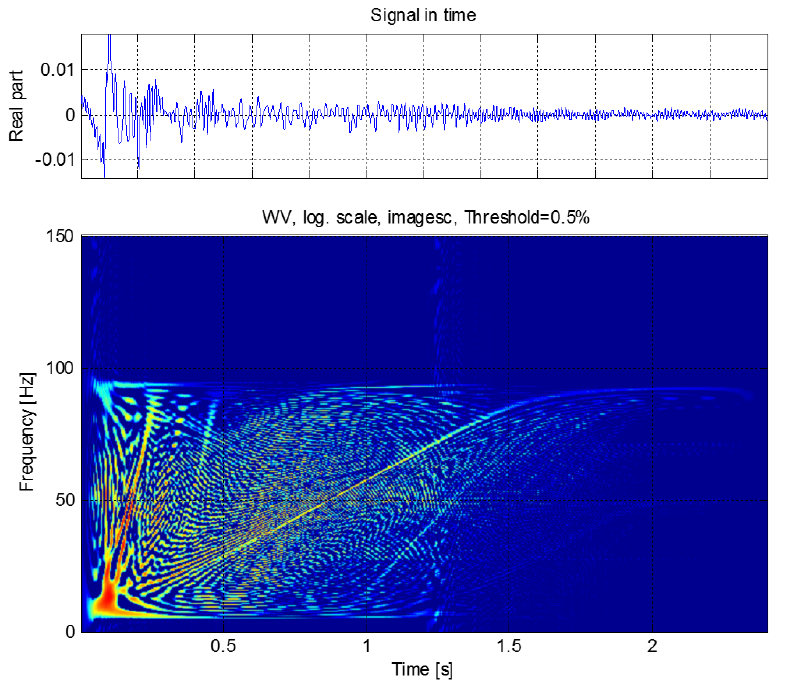
Figure 22. Components of the start-up current in the frequency band [2.93, 93.75] Hz, which includes the main outer race fault components ( top ) and Wigner–Ville distribution of these components ( bottom